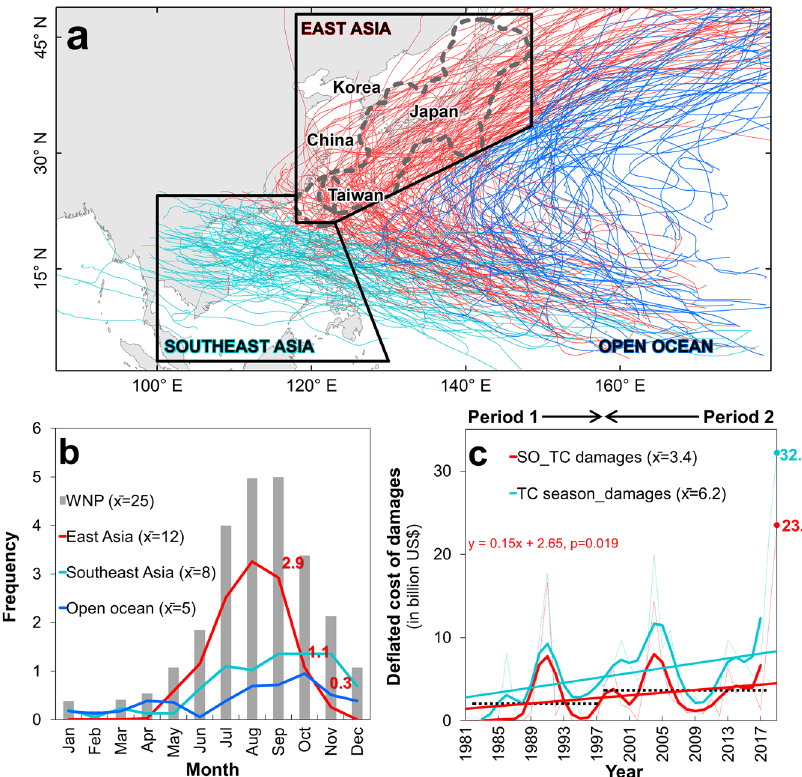
Fig. 1 Increasing cost of damages associated with tropical cyclones (TC) in East Asia (EA). a TC tracks during September − October (SO) in East Asia (red), Southeast Asia (cyan), and the open ocean (blue). The gray dashed lines represent the 225 km (175 km) buffer zone away from the nearest coastlines of Japan (Taiwan). b Mean monthly TC passage frequency in indicated domains. c TC-associated cost of damages in EA from June − October (cyan) and SO (red). The thick (thin) line represents the timeseries of the 1-3-4-3-1 fi ltered (raw) TC-associated cost of damages. The black dashed lines indicate the abrupt regime shift in mean TC-associated cost of damages during the Period 1 (1981 − 1997) and Period 2 (1998 − 2019), respectively. Signi fi cance is tested using student ’ s t-test statistic with two-tailed distribution.